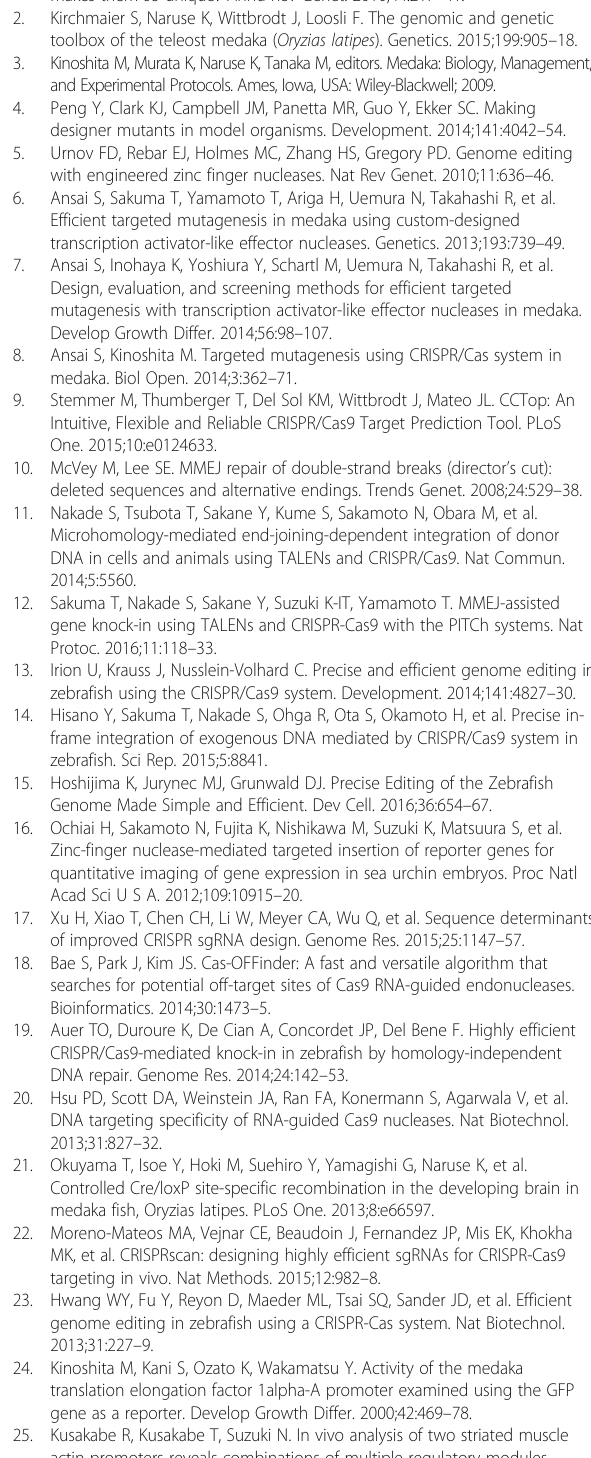
Additional file 2: Table S4. Oligonucleotide sequences used in this study. (XLSX 13 kb) Additional file 3: Figure S1. Selection of sgRNA targeting to the skeletal muscle-specific actin gene ( acta1 ) in medaka. (Upper): The design